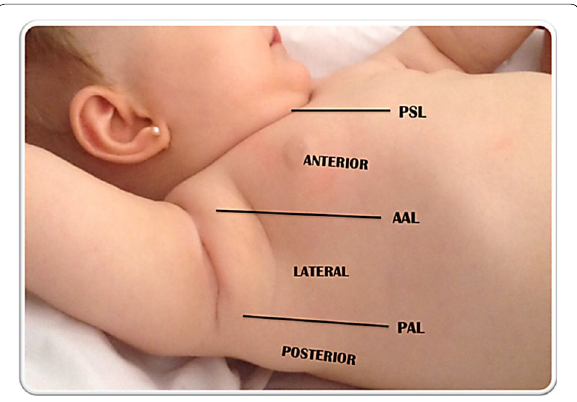
Fig. 1 Each hemithorax was divided into three regions: anterior, lateral, and posterior regions corresponding to the anatomical land‑ marks of the parasternal line , anterior and posterior axillary lines . AAL anterior axillary line; PAL posterior axillary line and PSL parasternal